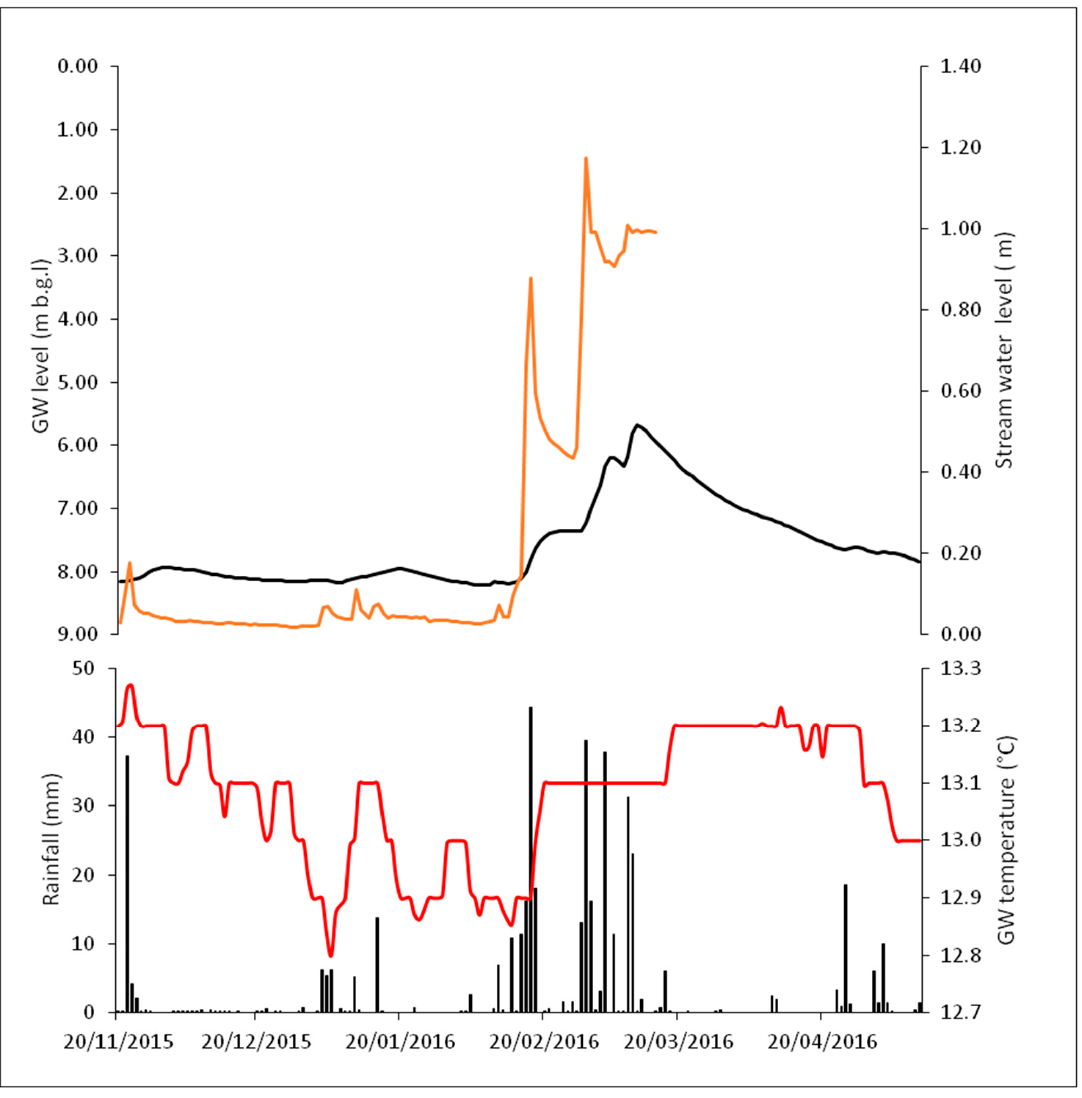
Figure 3. In-continuous daily groundwater levels (dark line) and temperatures (red line) detected in well W from the period 20 November 2015 to 11 May 2016. Daily precipitations (black bar) and stream water level (orange line) from R1 gauge are also reported (readers are referred to Figure 1 for the exact locations of W and R1).